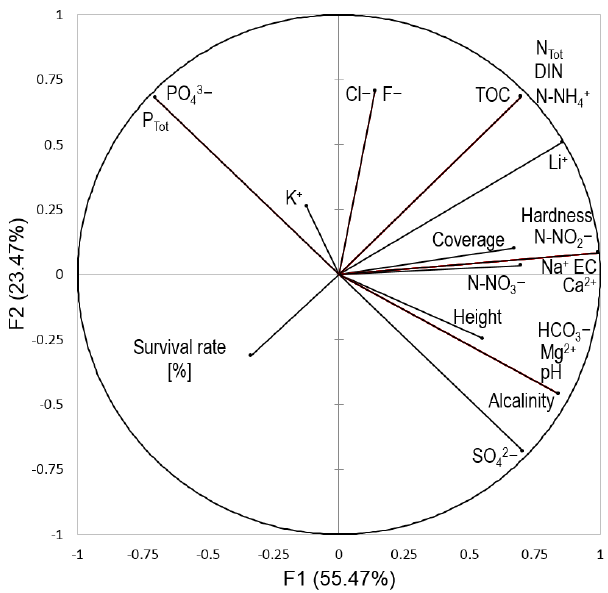
Figure 5. The PCA of the interrelations between the survival rates of Salix lapponum , acrotelm water chemistry, and the cover and height of the herbaceous layer. The survival rates of Salix lapponum were negatively correlated with the cover and height of the herbaceous layer but did not show significant correlations with the measured water chemistry parameters. This contrasts with the cover and height of the herbaceous layer, which showed correlations with a number of water chemistry parameters (Table 2). Table 2. Eigenvalues and loading of the calculated principal components